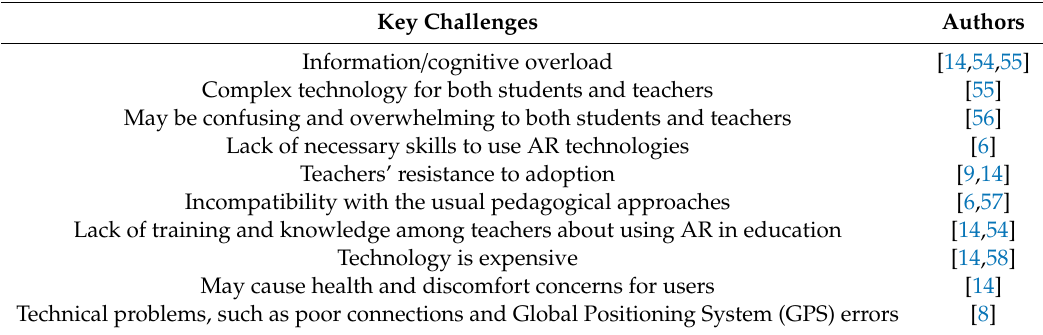
Table 4. Summary of the key